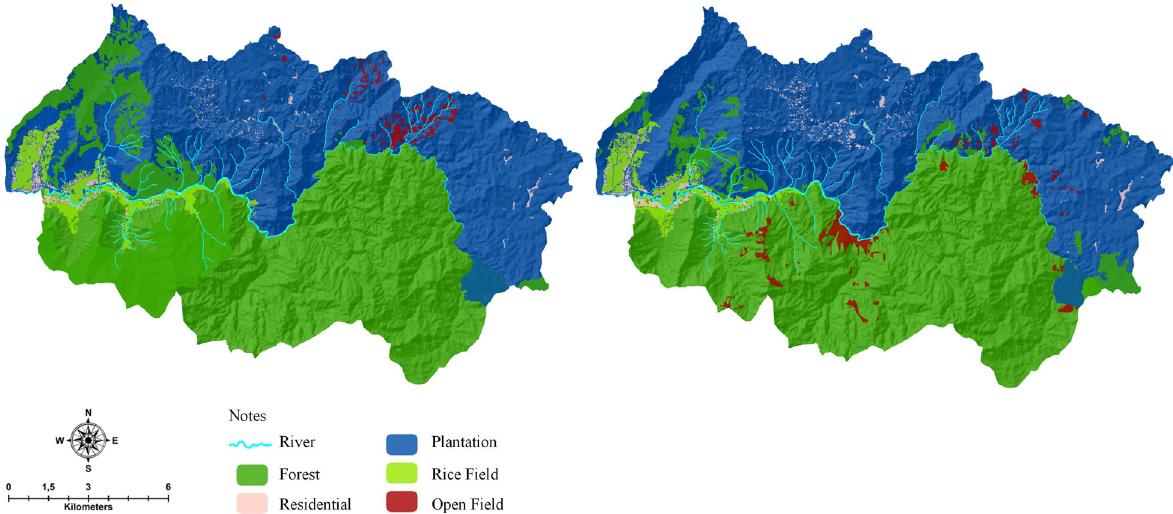
Fig. 4. land-use change in the Sanenrejo sub-watershed between 2011 (left) and 2019 (right). Source: own